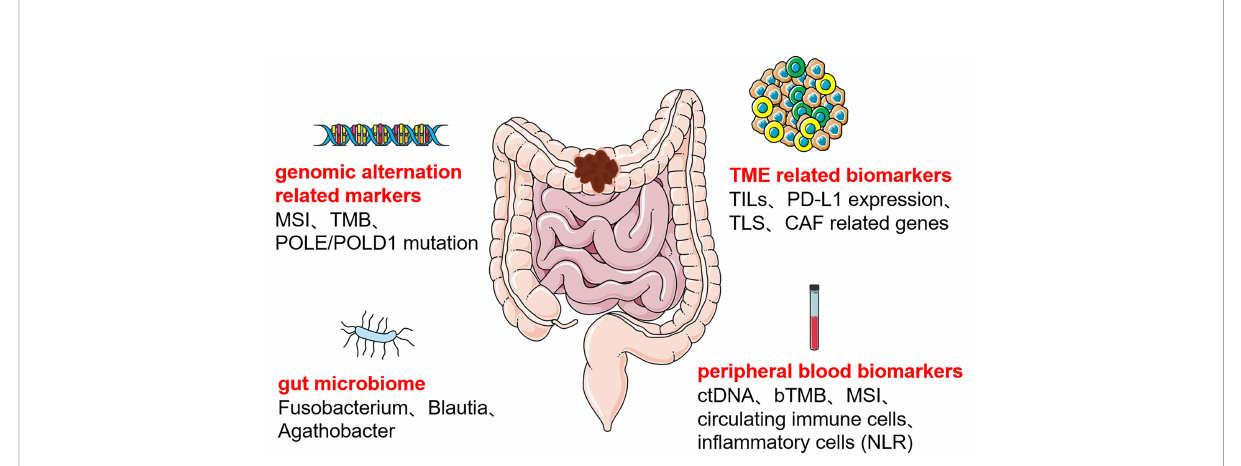
FIGURE 1 Predictive biomarkers of colon cancer immunotherapy MSI, microsatellite instability; TMB, total mutation burden; POLE:/POLD1, DNA polymerase ϵ (POLE) and d (POLD1); TILs, tumor-in fi ltrating lymphocytes; PD-L1, programmed cell death-ligand 1; TLS, tertiary lymphoid structure; CAF, cancer- associated fi broblast; ctDNA, circulating tumor DNA; bTMB, blood total mutation burden; NLR, neutrophil-lymphocyte